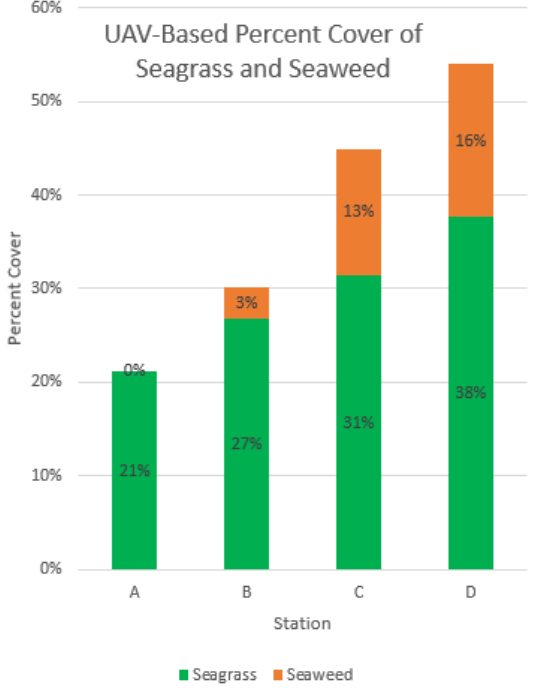
Figure 10. UAV-based percent cover estimation of seagrass and seaweed